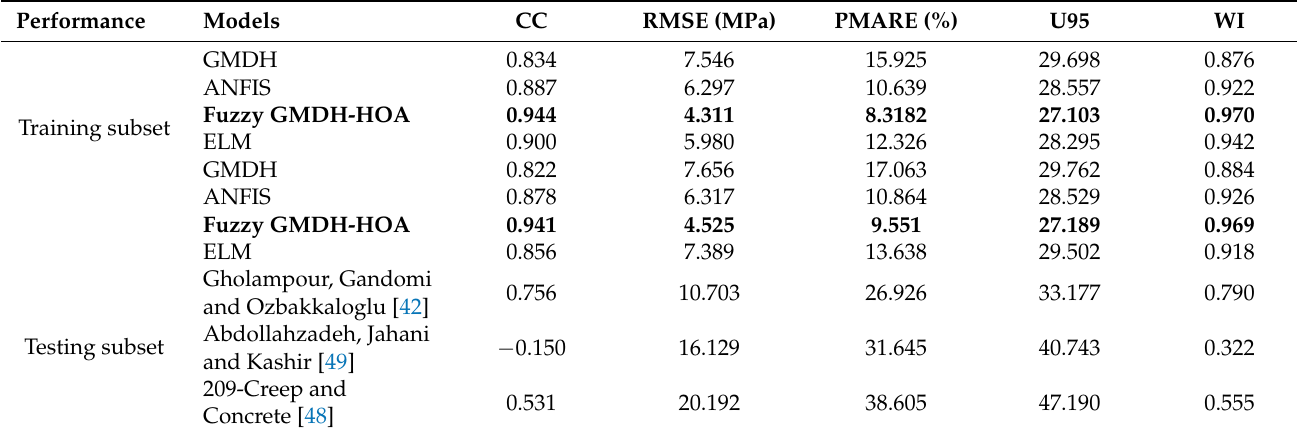
Table 4. Performance of predictive models.